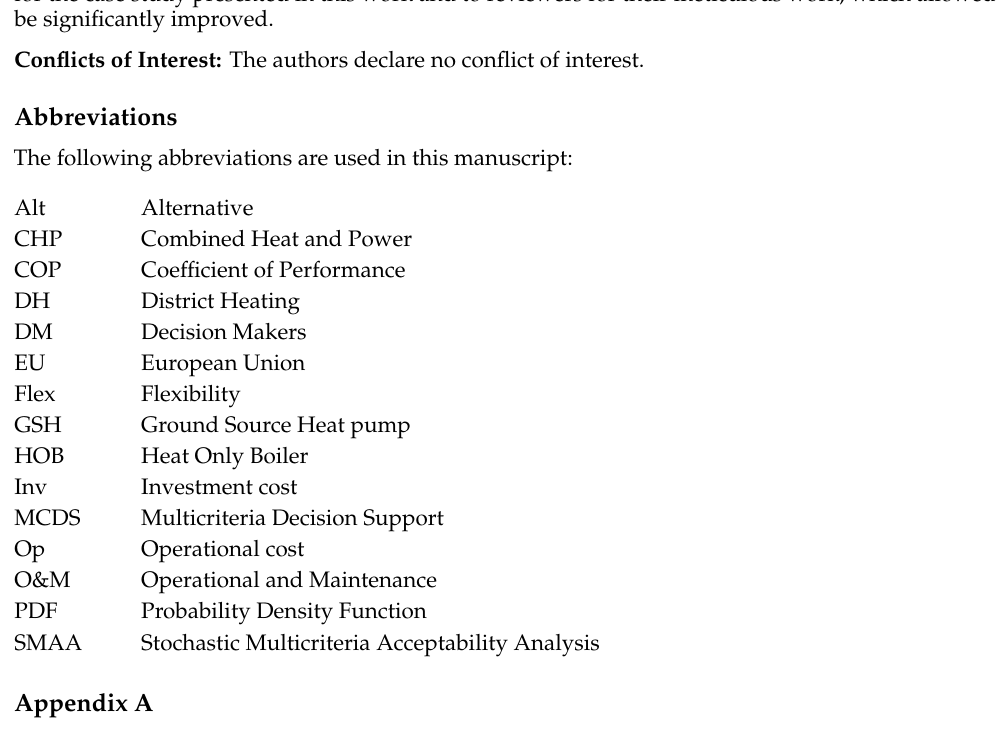
Table A1. Correlation matrix for uncertainty dependencies of criteria measurements